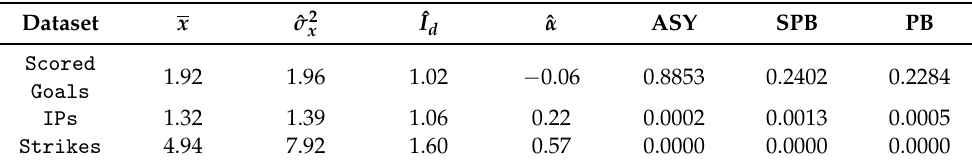
Figure 10. Estimated auto-correlations of the dataset Strikes : ( top panel ) autocorrelation function (ACF); ( bottom panel ) partial autocorrelation function (PACF). Table 4. Results of empirical